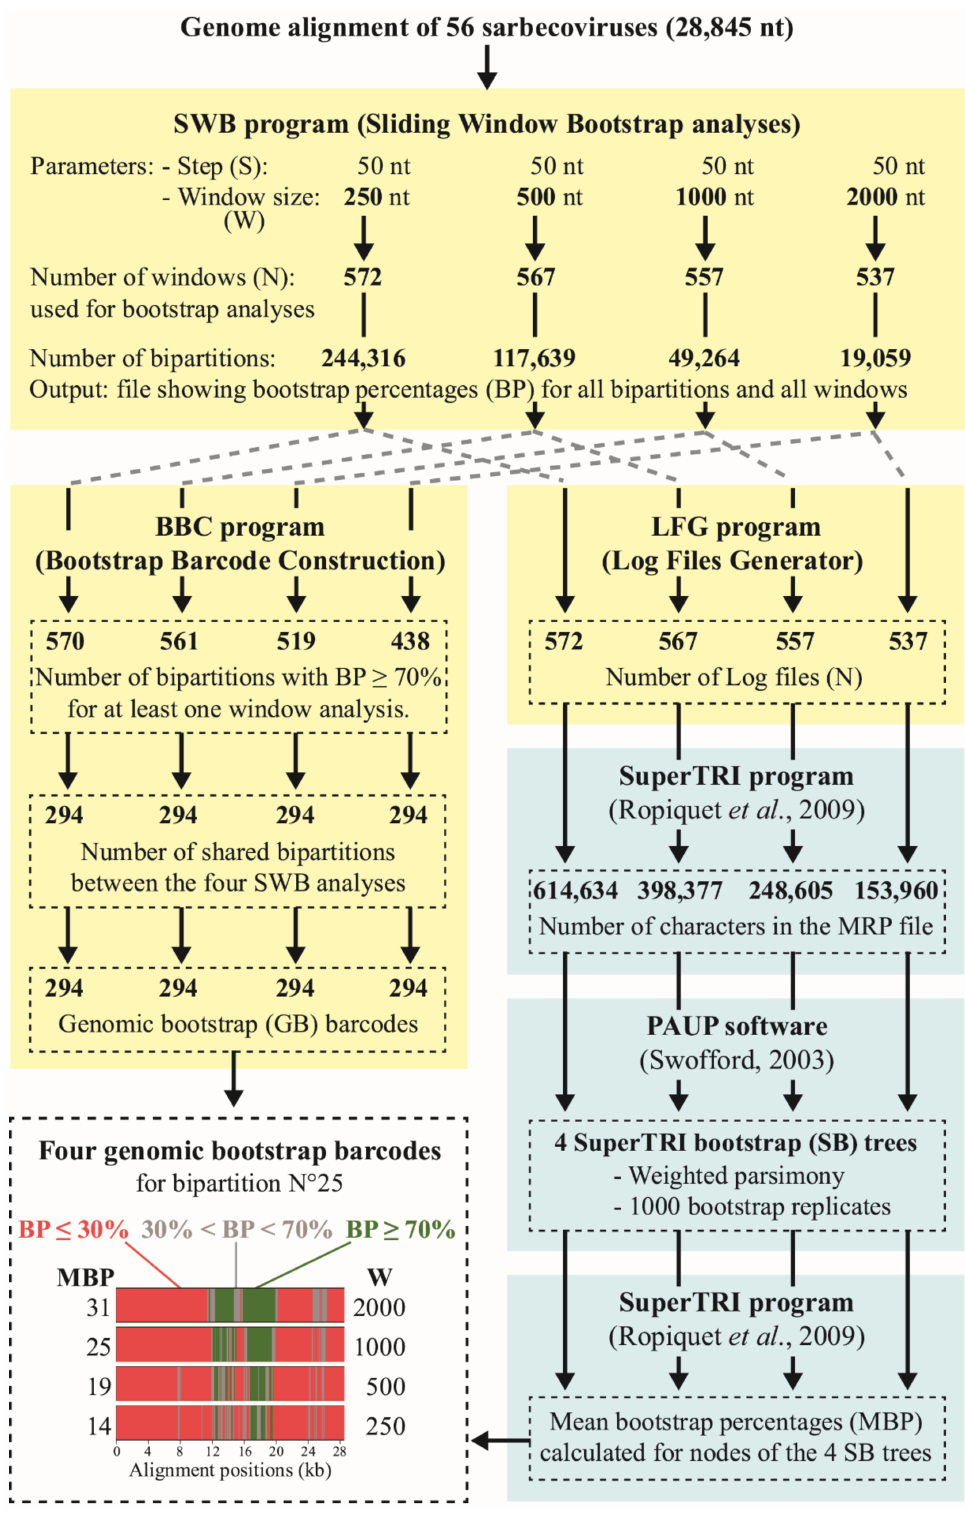
Figure 1. Diagram describing the programs used to construct genomic bootstrap barcodes and phylo- genetic trees. The programs SWB, BBC, and LFG were specially written for this study (highlighted in pale yellow). The SWB program was designed to generate bootstrap bipartitions from a sliding window of a specific width (W) moving in steps of 50 nt along the genome alignment. With W sets to 250 nt, N = 572 RAxML bootstrap analyses [23] were conducted (using a GTR+G model and 100 replicates), and the bootstrap percentages (BP) calculated in each of the 572 analyses were